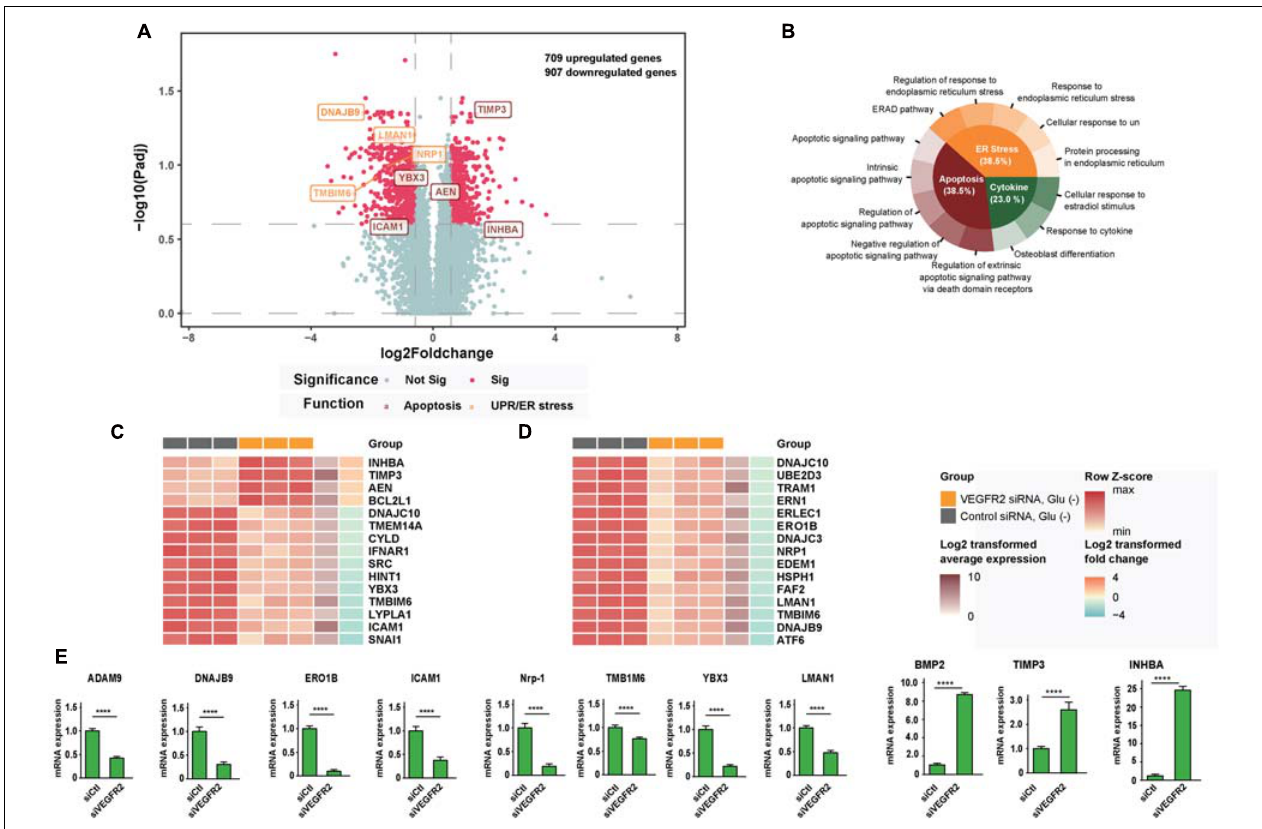
FIGURE 2 | RNA-seq analysis links cell death rescue by deletion of VEGFR2 to ER stress and UPR-related signaling pathways upon glucose deprivation. (A) The volcano plot shows gene expression changes mediated by VEGFR2 knockdown, with ER stress and apoptosis genes highlighted. X -axis: log2 fold-change of gene expression between groups. Y -axis: -log10 adjusted P values of gene expression between groups. (B) GO and KEGG enrichment results showed that the biological terms affected by VEGFR2 knockdown were divided into three categories: apoptosis, ER stress, and cytokine. (C) Heatmap of differential gene expression in the apoptosis category. (D) Heatmap of differential gene expression in ER stress category. (E) Validation of differentially expressed genes by rt-PCR. (A–E) n = 3/group. All error bars indicate S.D. Unpaired student’s test, **** P <